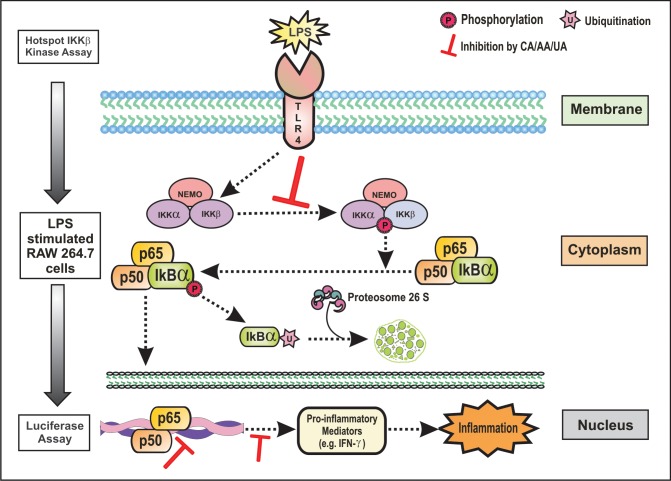
Proposed mechanism of action of pentacyclic triterpenoids on LPS induced NF-κB signaling.Abrogation of NF-κB activation by pentacyclic triterpenoids may be resulted due to down regulated IKKβ phosphorylation.